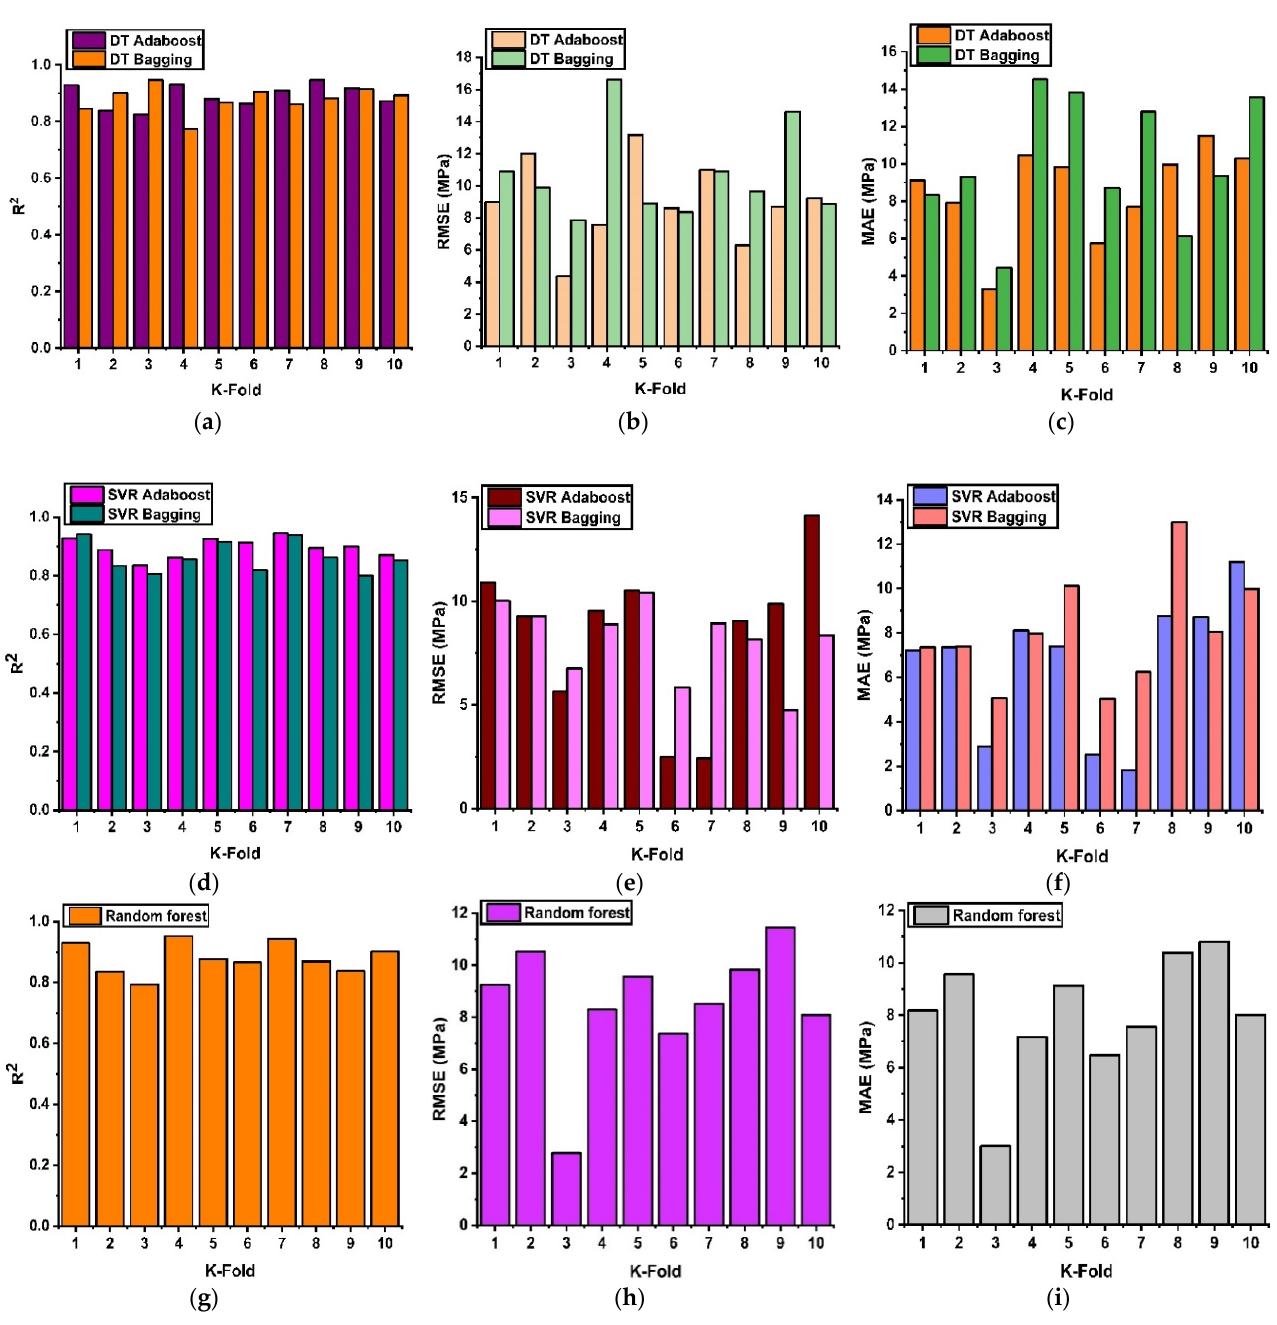
Figure 8. K-fold validations; ( a ) DT correlation with ensemble models; ( b ) DT RMSE errors with ensemble models; ( c ) DT MAE errors with ensemble models; ( d ) SVR correlation with ensemble models; ( e ) SVR RMSE errors with ensemble models; ( f ) SVR MAE errors with ensemble models; ( g ) RF correlation with ensemble models; ( h ) RF RMSE errors with ensemble models; ( i ) RF MAE errors with ensemble models.